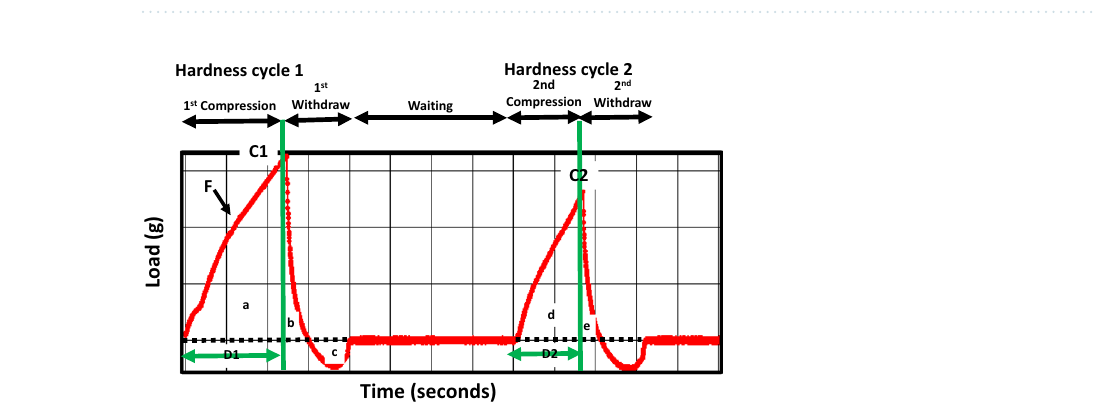
Figure 4. The internal white fiber bundles terminal to the mesocarp of selected date fruits.